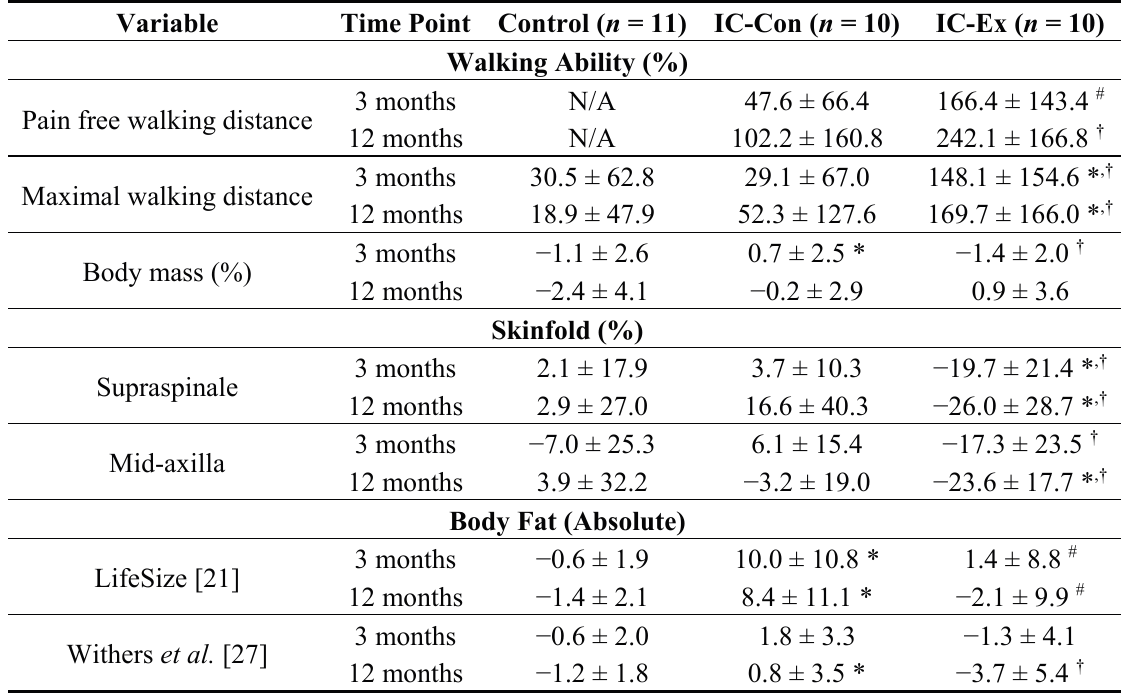
Table 3. Absolute or relative (%) change in walking ability, anthropometric measures and body fat of healthy adults (Control) and age- matched patients with intermittent claudication undertaking 3 and 12 months of usual care (IC-Con) or regular supervised exercise training